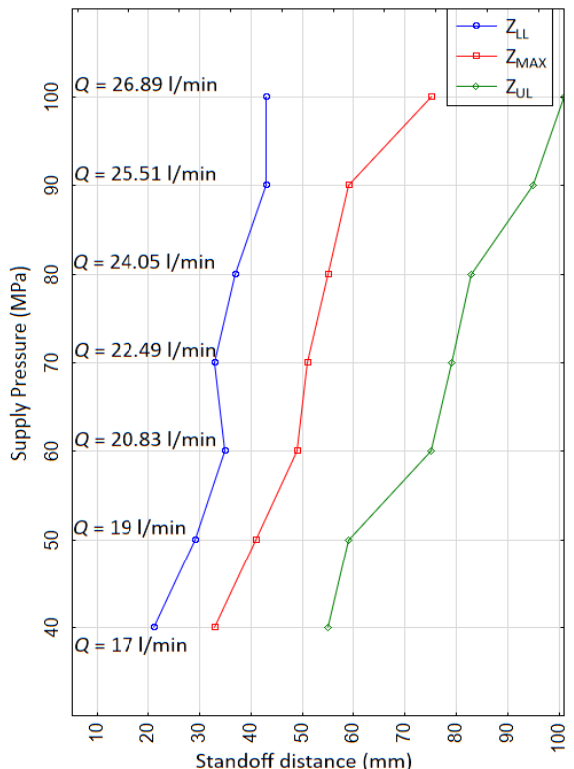
Figure 12. Variation in the erosion interval with standoff distance ( z = 5 to 101 mm) and supply pressure ( p = 40 to 100 MPa) at constant traverse speed ( v = 5 mm/s).